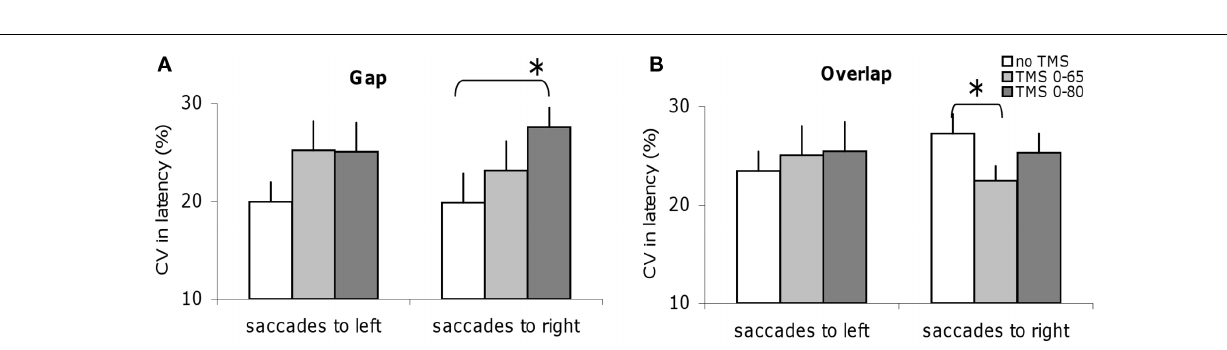
FIGURE 4 | Group mean latencies with SE for saccades to left or right in different dTMS conditions: no dTMS, dTMS 0–65ms, dTMS 0–80ms under the tasks gap (A) and overlap (B). Asterisks indicate a significant effect on group mean latencies of dTMS with an ISI of 65 or 80ms versus control no dTMS.